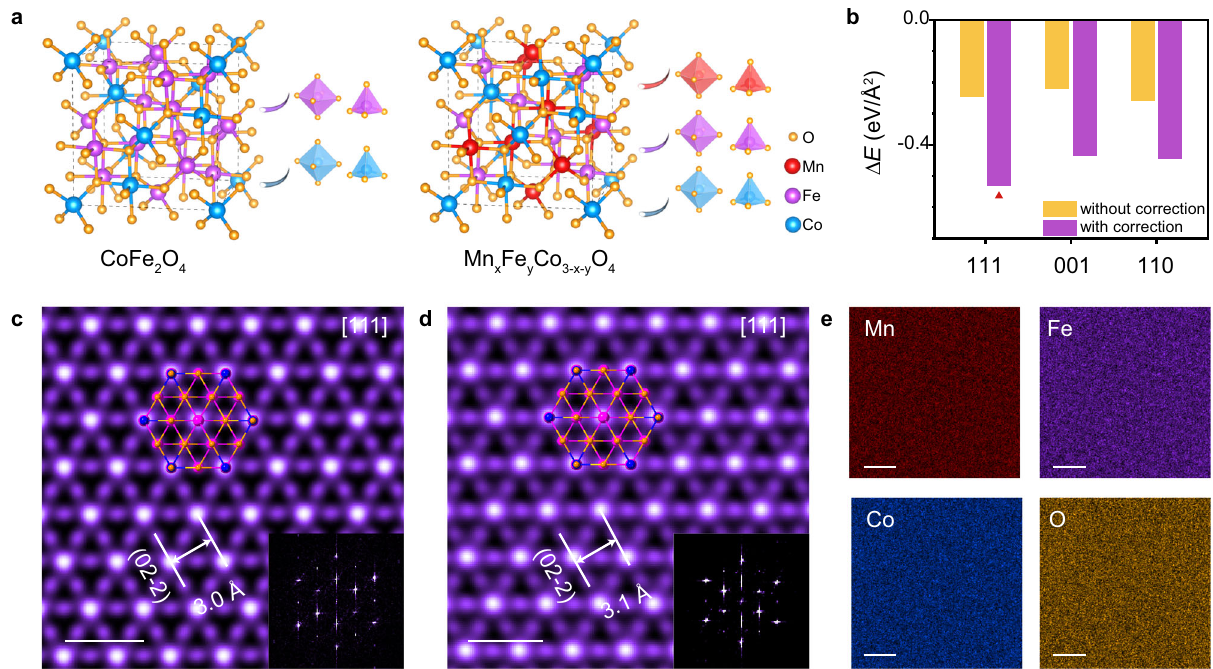
Fig.4|TTCGmodelformulti-elementoxides.a StructuremodelsofCoFe 2 O 4 and inserted with corresponding projected atomic models along the [111] orientation. Mn x Fe y Co 3-x-y O 4 . Metal ions occupy the centers of tetrahedrons or octahedrons The orange, purple, and blue spheres represent O atoms, octahedral sites, and tetrahedral sites, respectively. Inset shows the corresponding FFT pattern, indi- sites surrounded by oxygen atoms. Dashed rectangles represent unit cells. b Total Δ E with and without circumstance correction terms for CoFe catingthe[111]orientation. e 2 O 4 with different orientations based on the TTCG model. Red triangles indicate the lowest energy. c , d Top-viewSTEM-ADFimagesofCoFe 2 O 4 ( c )andMn x Fe y Co 3-x-y O 4 ( d )nano fl akes,